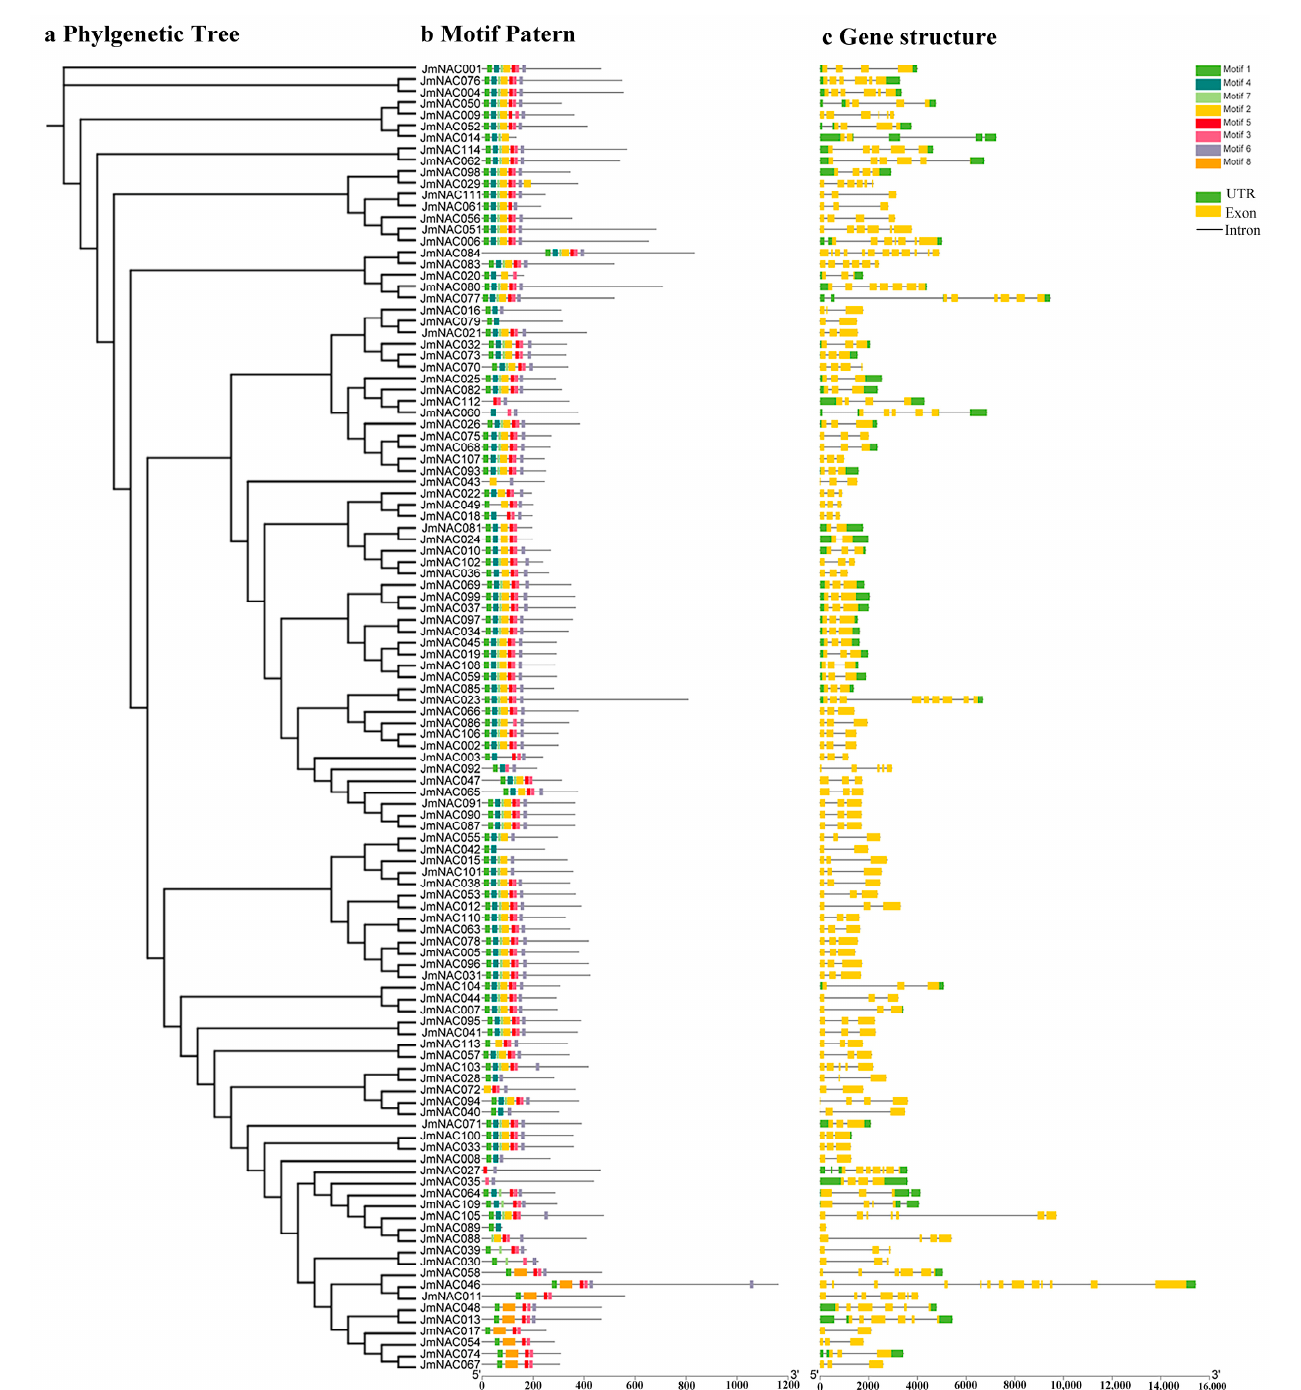
Figure 3. Phylogenetic relationships, gene structure and protein motifs in JmNAC genes. ( a ) The phylogenetic tree of all NAC proteins in J. mandshurica was constructed using the neighbour-joining method with 1000 replicates in the MEGA 7.0 software (Mega Limited, Auckland, New Zealand). ( b ) The motif composition of J. mandshurica NAC proteins. Motifs 1–10 are displayed in different coloured boxes. ( c ) CDS–UTR structure of JmNAC genes. Yellow boxes represent CDS; black lines indicate introns; green boxes represent the untranslated 5 ′ and 3 ′ regions.